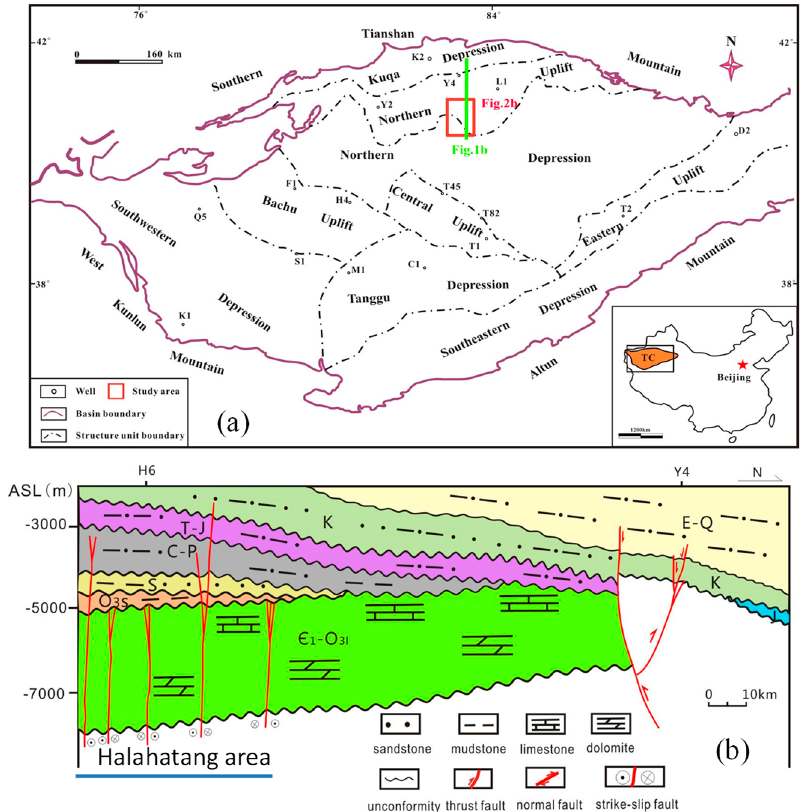
Figure 1. ( a ) The tectonic division of the Tarim Basin (the lower right inset map shows its location in China) (after [30]); ( b ) Geological profile across the study area (the upper strata of ~3000 m Cretaceous-Quaternary are omitted in the cross-section; modified from [30]). є : Cambrian; O 3l : Upper Ordovician Lianglitage Formation; O 3 s: Upper Ordovician Samgtamu Formation; S: Silurian; C-P: Carboniferous-Permian; T: Triassic; J: Jurassic; K: Cretaceous; E-Q: Eocene-Quaternary.